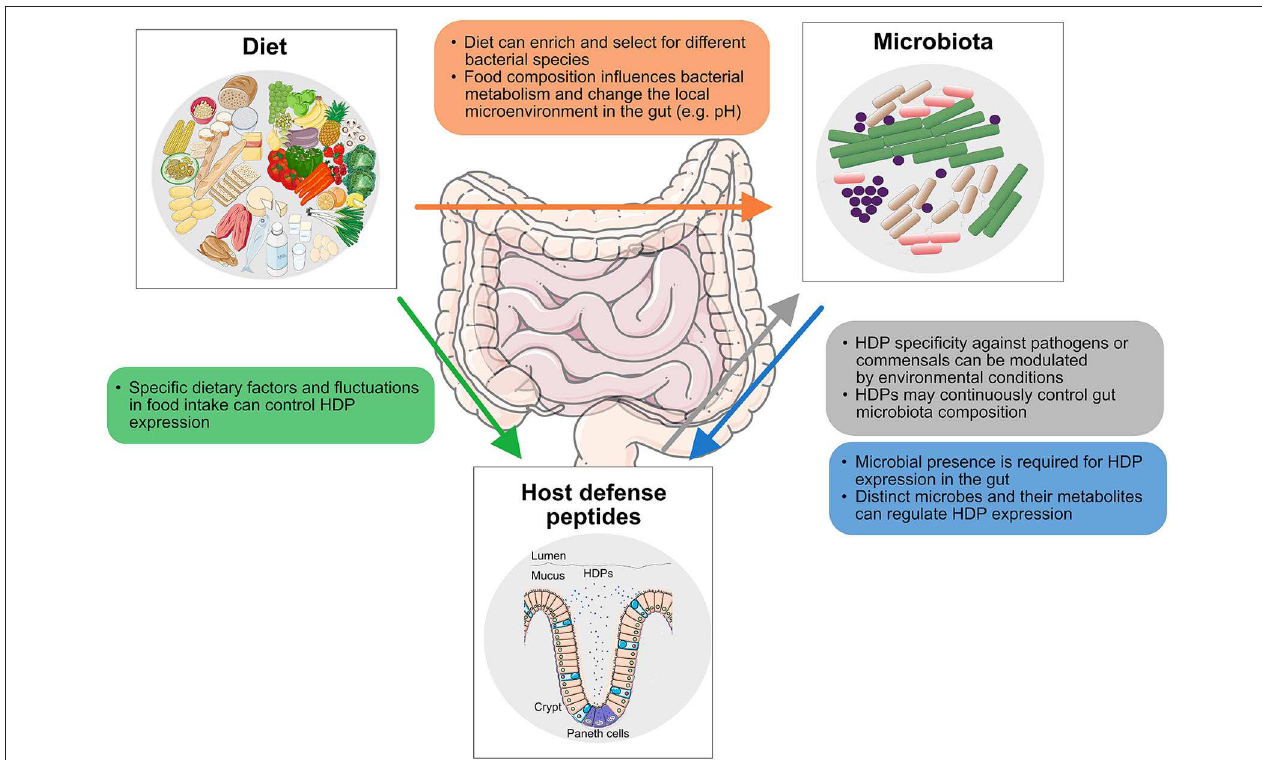
FIGURE 1 | Interactions along the diet-HDP-microbiota axis discussed in this study. The impact of diet on gut microbiota composition (orange), the effect of diet on host defense peptide (HDP) expression (green), the activity of HDPs against gut microbes (gray), and the influence of bacteria and associated metabolites in HDP expression (blue) are displayed.